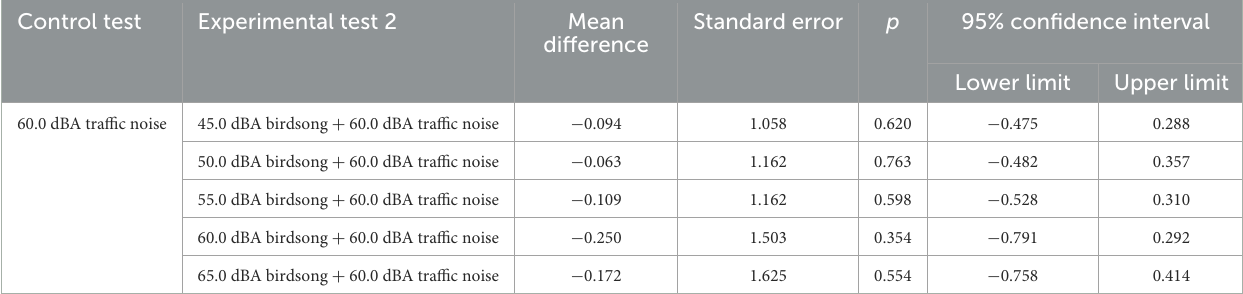
TABLE 5 Comparisons between the psychological health values on the cognitive dimension in the control test and experimental test